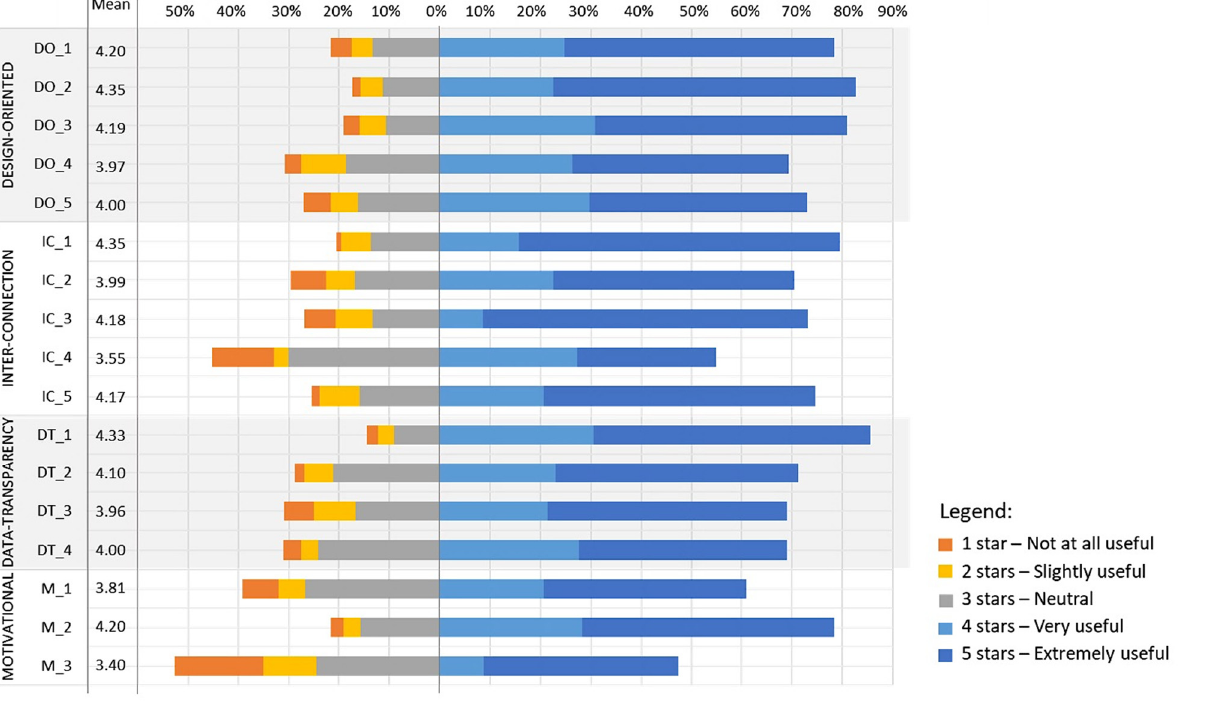
Figure 3. Attribute’s star rating. Design-oriented: DO_1 (Compare results with other buildings or design alternatives); DO-2 (Show graphical outputs); DO_3 (Provide a pre-set library with predefined WBLCA assumptions); DO_4 (Save previous design solutions); DO_5 (Suggest design alter-